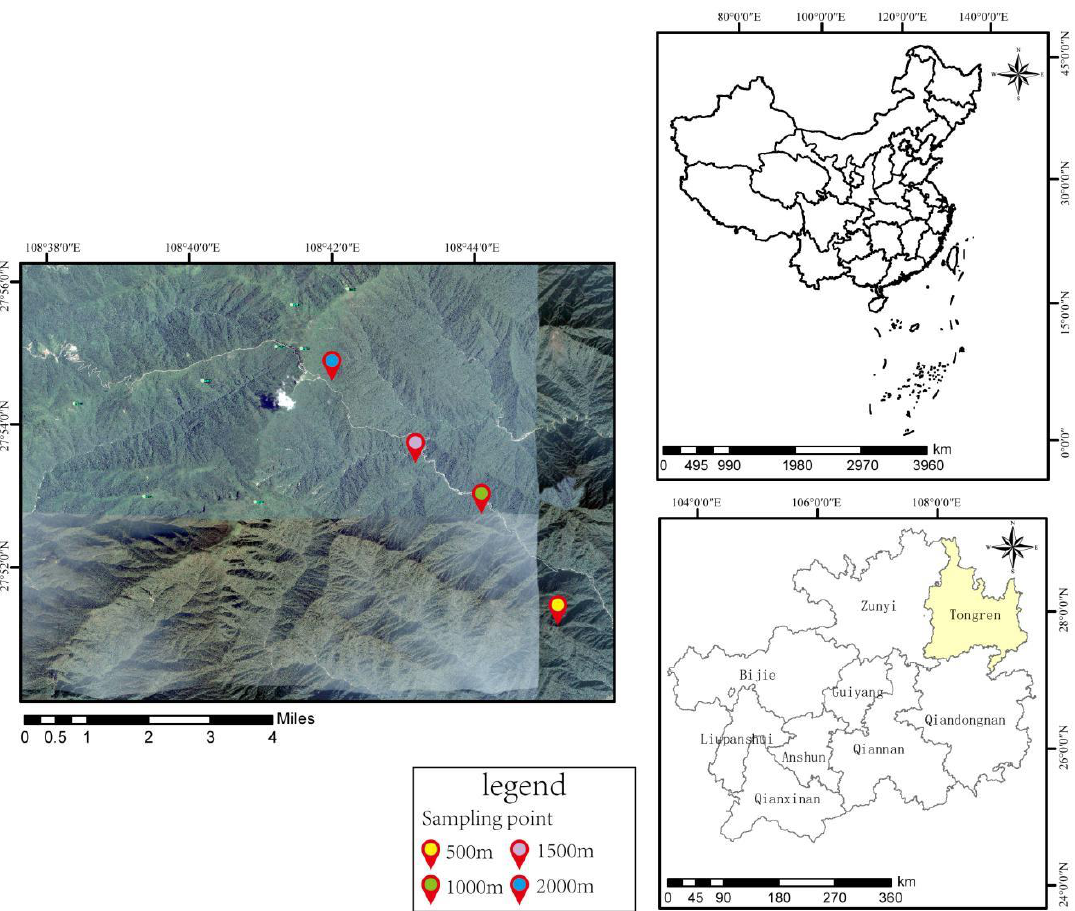
Figure 1. Location of the study area in Mount Fanjing. Table 1. Environmental factors of sample plot.